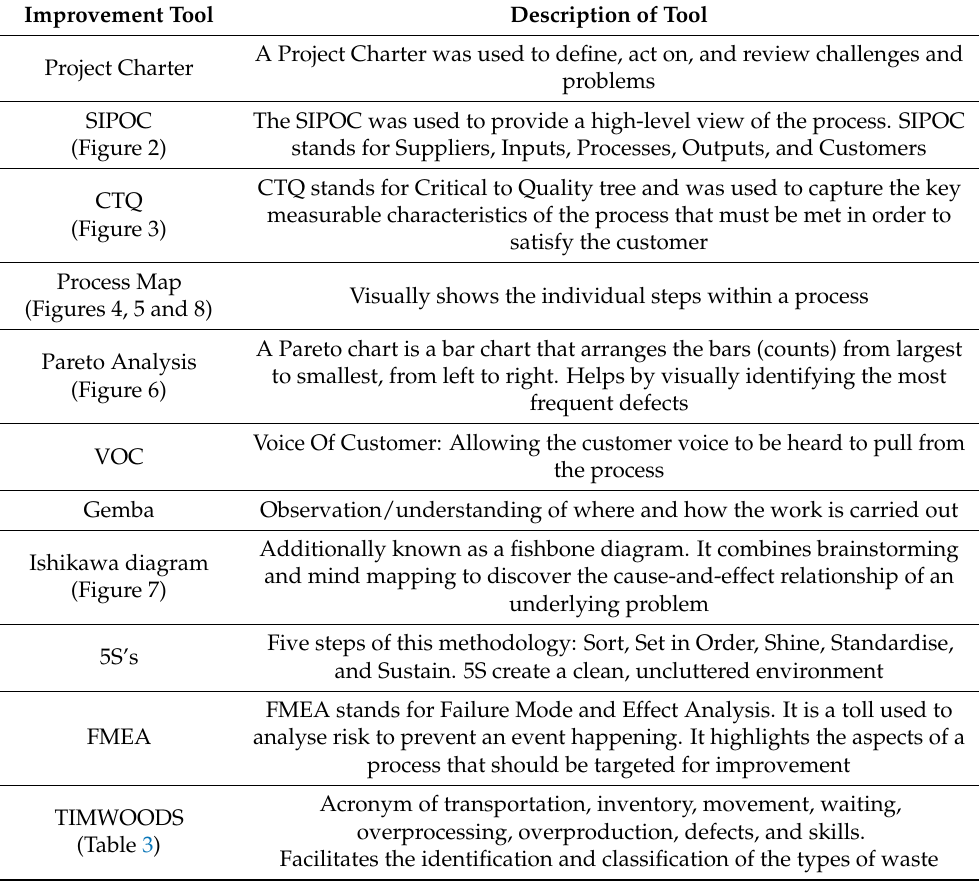
Acronym of transportation, inventory, movement, waiting, overprocessing, overproduction, defects, and skills. Facilitates the identification and classification of the types of